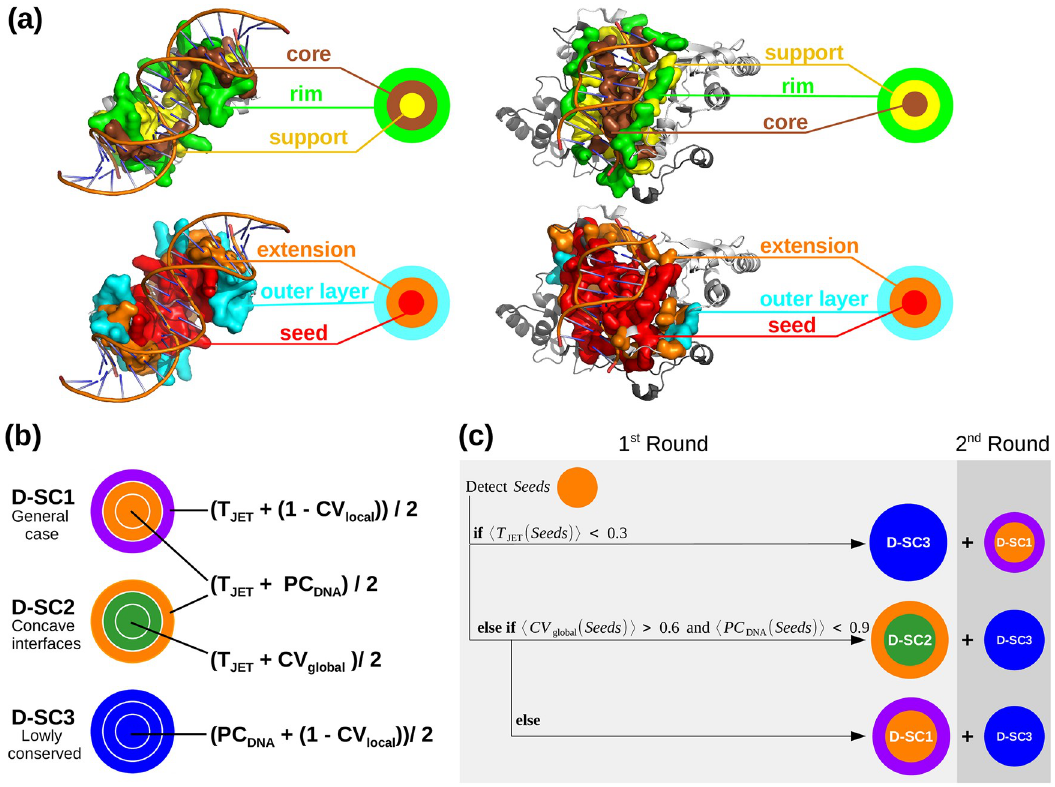
Fig 1. Experimental interface definition, JET 2 scoring schemes and complete automated clustering procedure. (a) Top, DNA sections of two experimental interfaces (on the left, PDB code: 1JE8; on the right, PDB code: 1D02). Bottom, the corresponding prediction using D-SC2. The experimental and predicted interface residues are displayed in opaque surfaces: support , core JET 2 DNA and rim are in yellow, brown and green, respectively; cluster seed , extension and outer layer are in red, orange and cyan, respectively; (b) Schematic representation of the three scoring schemes provided in JET 2 . T JET : conservation level, PC DNA : protein-DNA DNA interface propensities, CV local and CV global : local and global circular variance computed with a radius of 12 Å and 100 Å , respectively. Different colors correspond to different combinations of properties used to predict interface residues in the three steps of the clustering procedure. (c) Schematic representation of the complete automated JET 2 clustering procedure. DNA